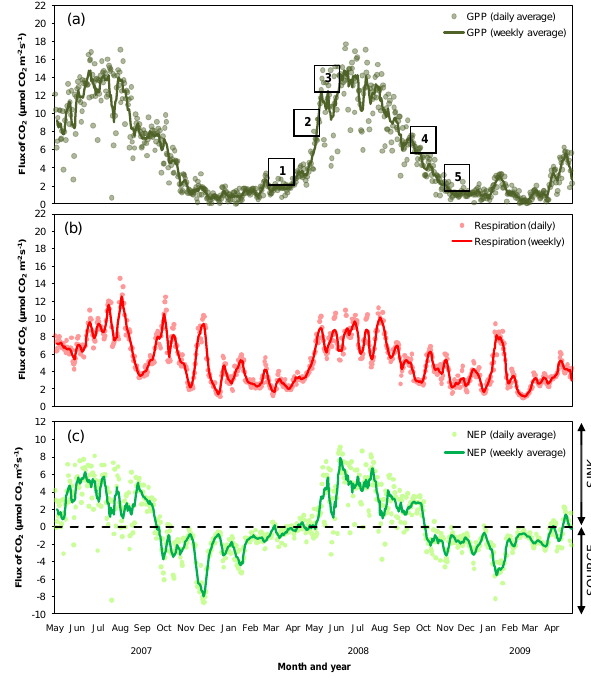
Fig. 6. Partitioned flux from Wytham Woods showing (a) gross pri- mary productivity (GPP), (b) ecosystem respiration ( R e ) and (c) net ecosystem productivity (NEP) over the study period. Dots indicate daily mean values, lines trace weekly mean values. Stages of GPP rise have been overlaid; stage (1) suggests the period of ground flora activity, stage (2) the period of rapid canopy leaf-out, and stage (3) the slow rise to mid-summer peak. Stages of GPP decline rep- resent (4) peak litterfall in early to mid October and (5) minimum leaf area